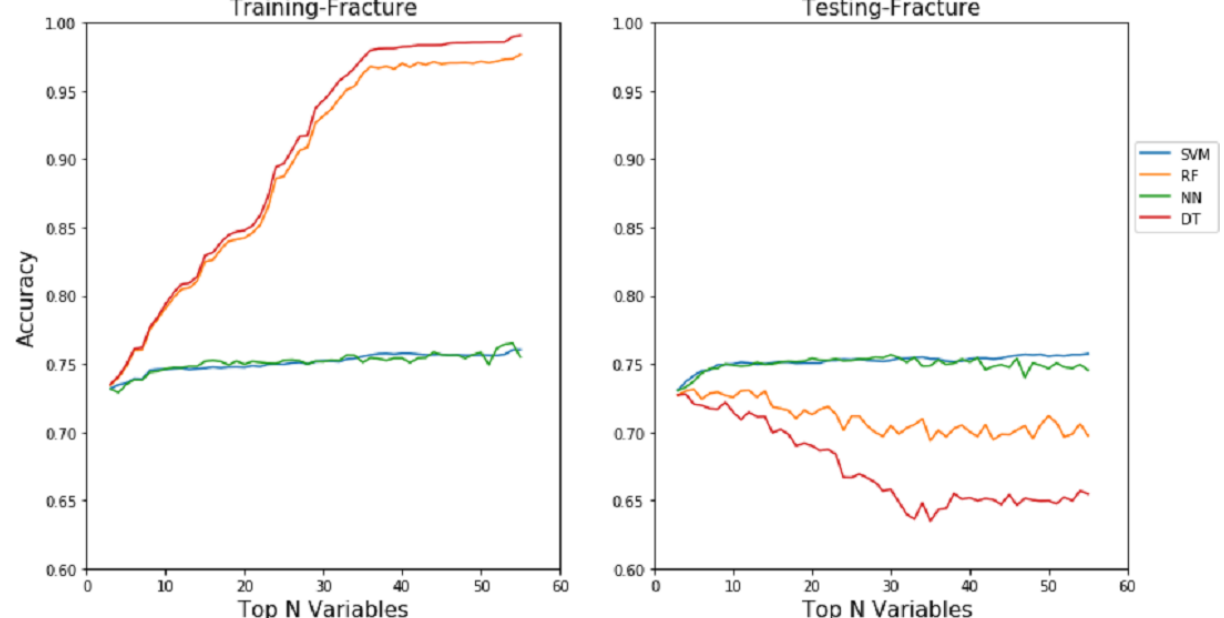
Figure 4. Train accuracy (left) and test accuracy (right) for fracture data without performing parameter tuning and using all the feature subsets (from top 3 to top 58 feature subsets). The left plot shows that random forest and decision tree overfit the training data, which poorly generalize on the test data as the number of features